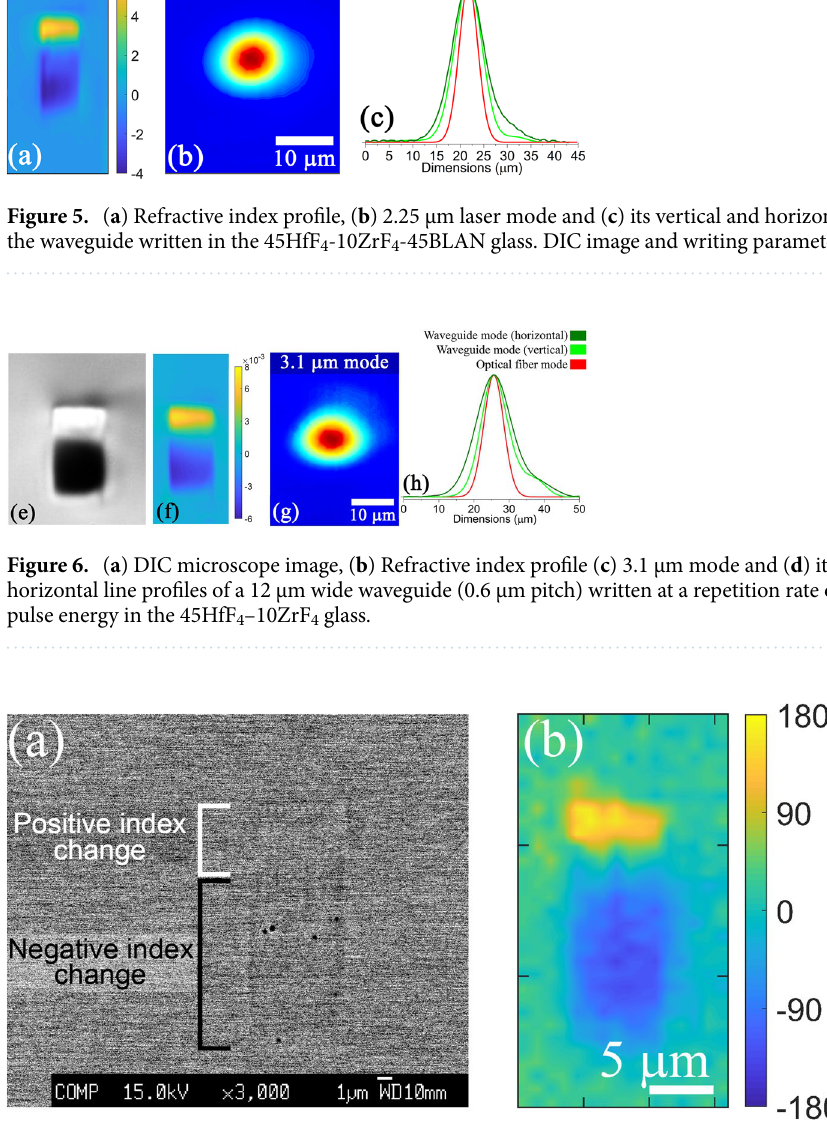
Figure 7. ( a ) Backscattered electron microscope image of the 7 μm wide waveguide written in the 45HfF 4 –10ZrF 4 –45BLAN glass. DIC image and writing parameters as in Fig. 4. Dark round spots within the negative index change zone are the nano-voids. ( b ) Brillouin frequency shift mapped across the same